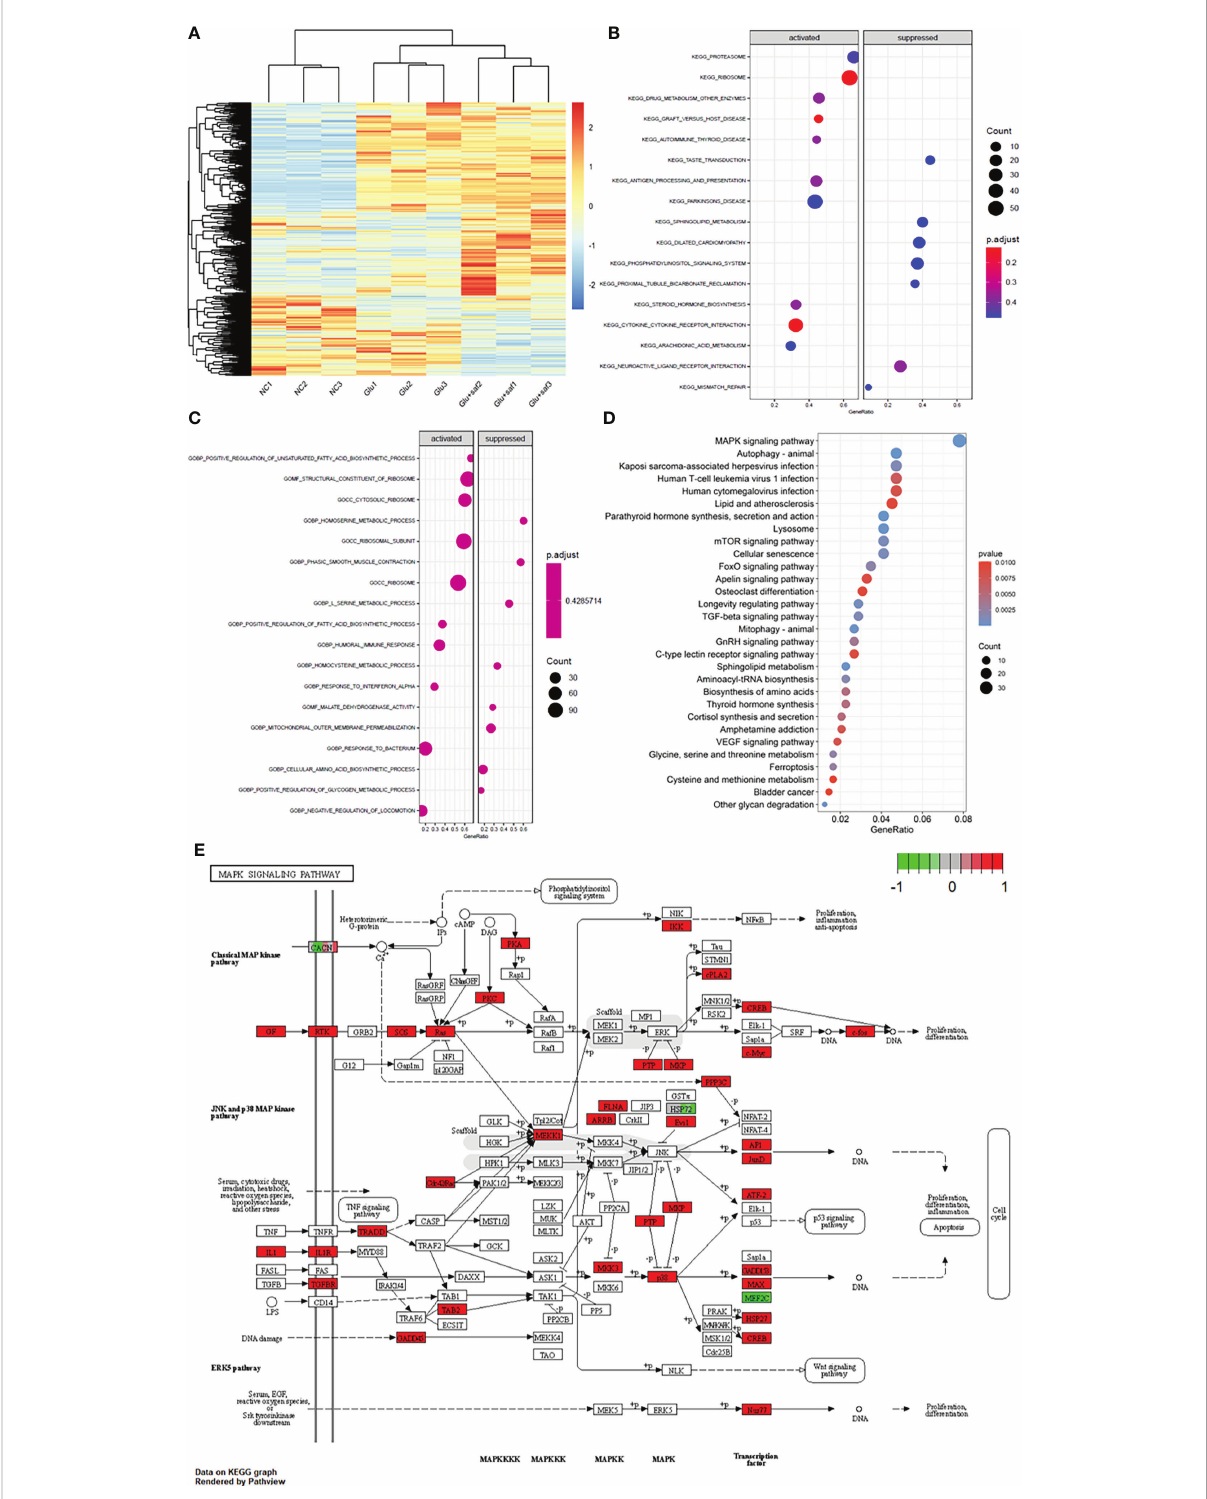
FIGURE 4 Transcriptome sequencing results. (A) shows the heat map of the three groups including the negative control, high glucose group, and high glucose treated with safranal group. (B, C) demonstrate the Kyoto Encyclopedia of Genes and Genomes (KEGG) and Gene Ontology (GO) results between the high glucose group and high glucose treated with safranal group. From the bubble graph, the MAPK signaling pathway demostrateda high gene ratio (D) and the detailed pathway was demonstrated in (E)